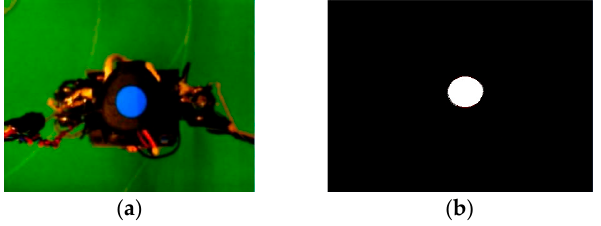
Figure 6. Robot’s mark captured by the CMOS sensor: ( a ) original image; ( b ) filtered image.